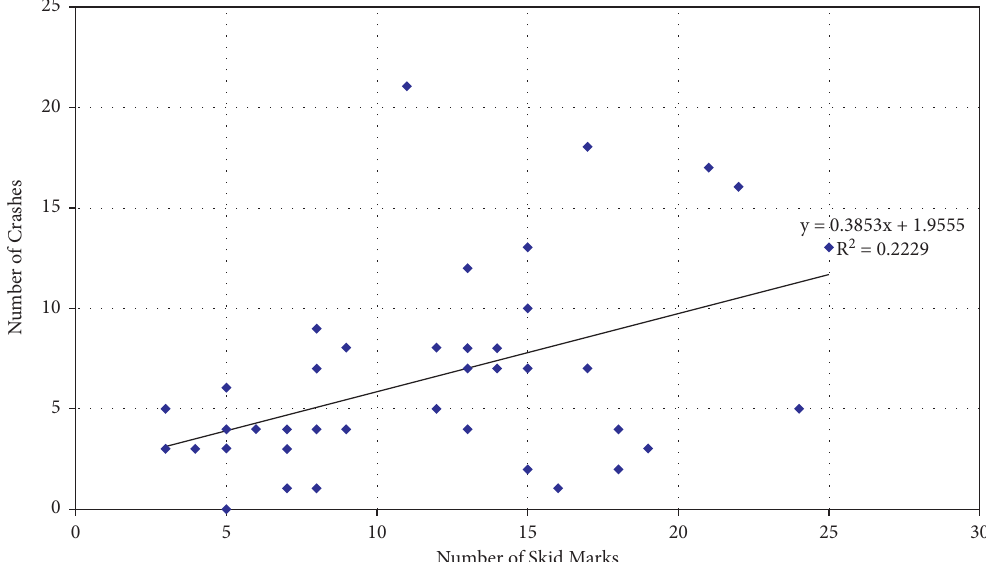
Figure 14: Sliding windows rear-end crash vs. skid correlation on Interstate 80 westbound (1.0-mile windows, 0.20-mile step).